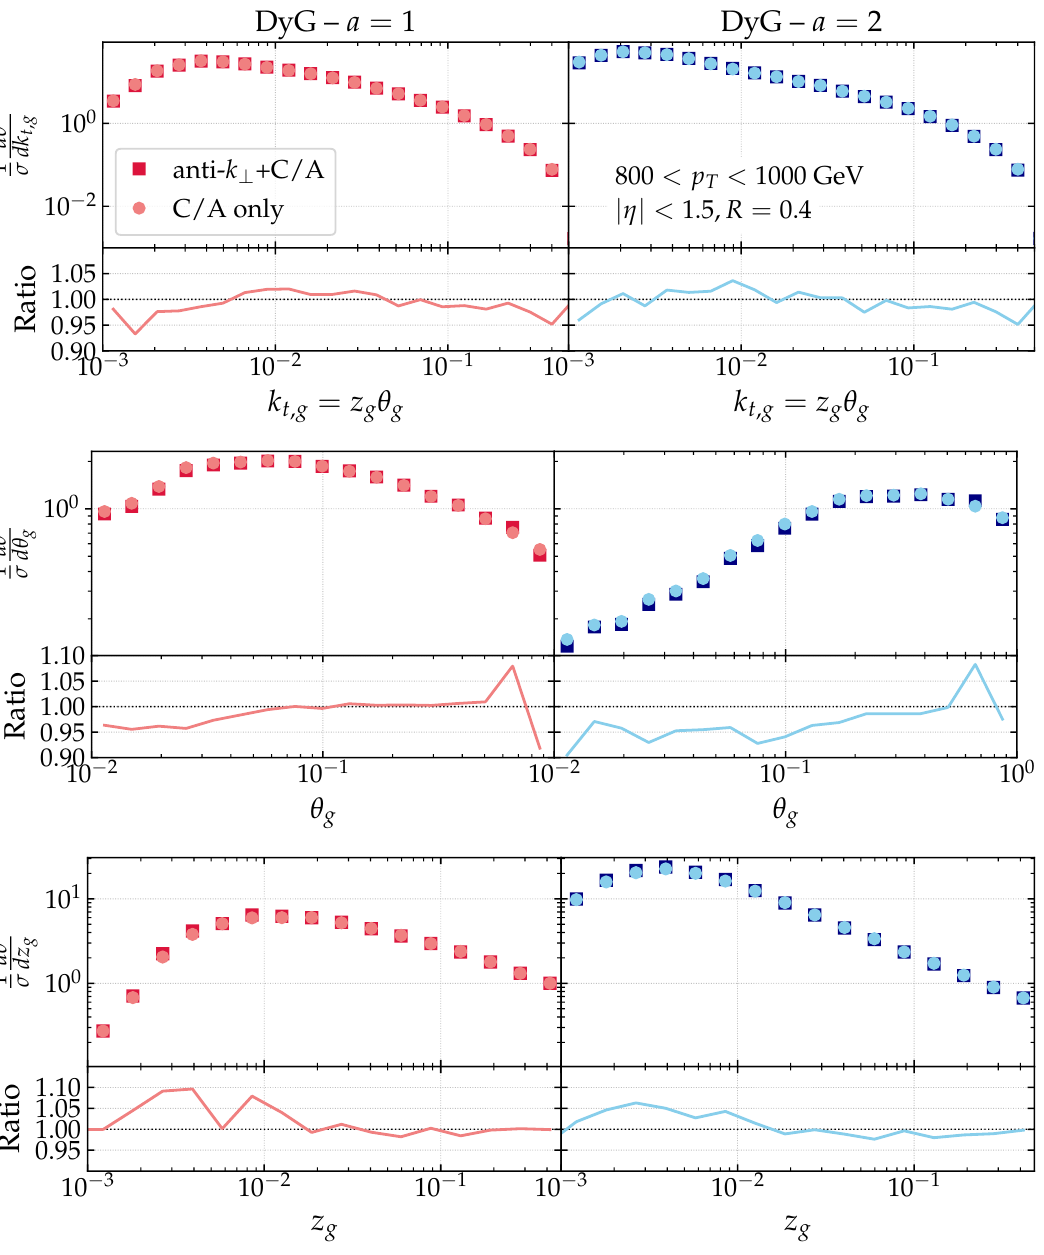
Figure 12 . Impact of different clustering strategies in k t,g as a function of a for dijet events at √ parton level in PYTHIA with s =13 TeV for k t,g (top), θ g (center) and z g